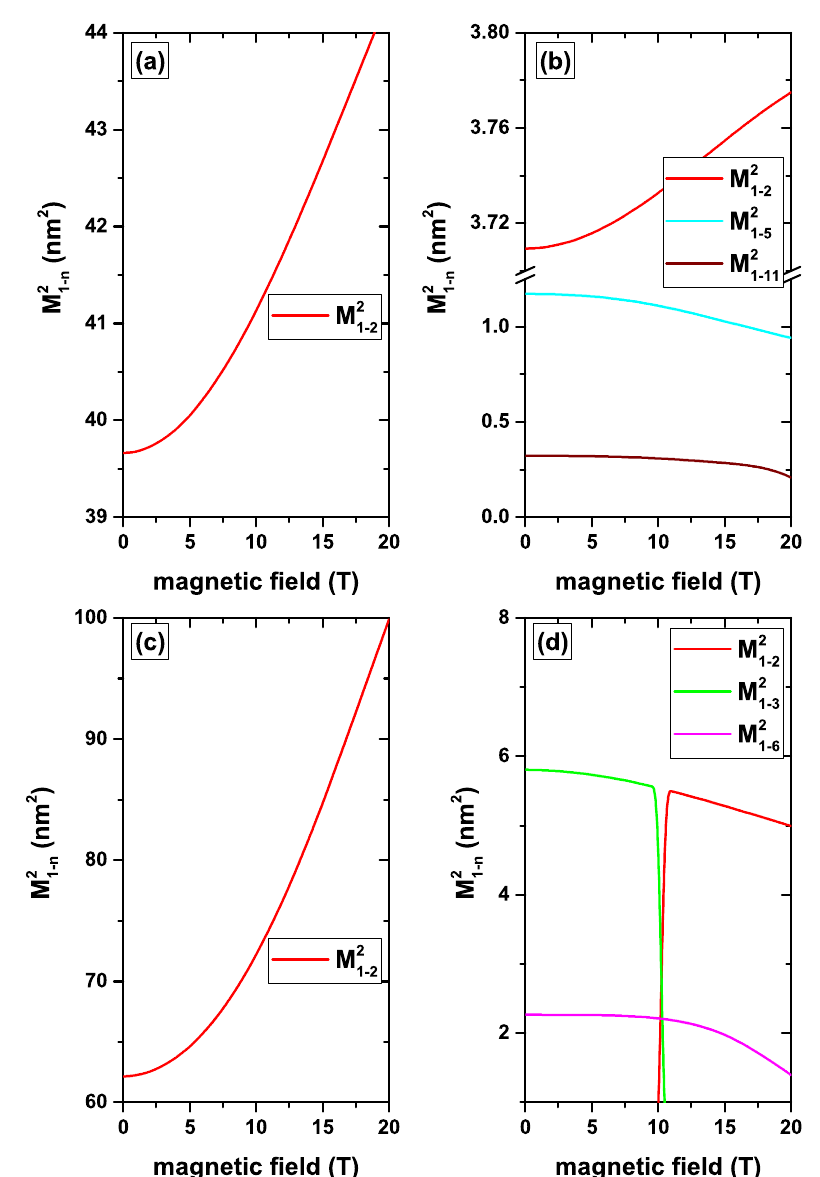
Figure 8. (color online) The squared matrix elements of the transitions from the ground state to the first fourteen excited states with l = 0 ( | 1 (cid:105) → | n (cid:105) , with n = 2,3, . . . ,15) for a confined electron in a CdS/ZnS spherical QD as functions of the MF. Results are without ( a , c ) and with ( b , d ) on-center donor impurity, with R 1 = 20nm and R 2 = 30nm. Calculations are for zero EF ( a , b ) whereas in ( c , d ) the results are for F = − 20kV/cm, central